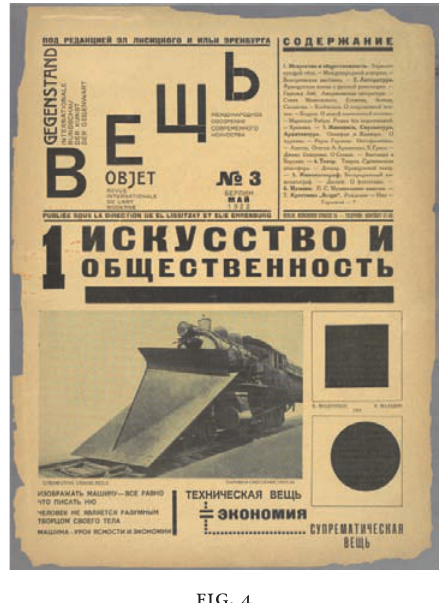
fig. 3 “Vešč’-Gegenstand-Objet”, i-ii, p. 1